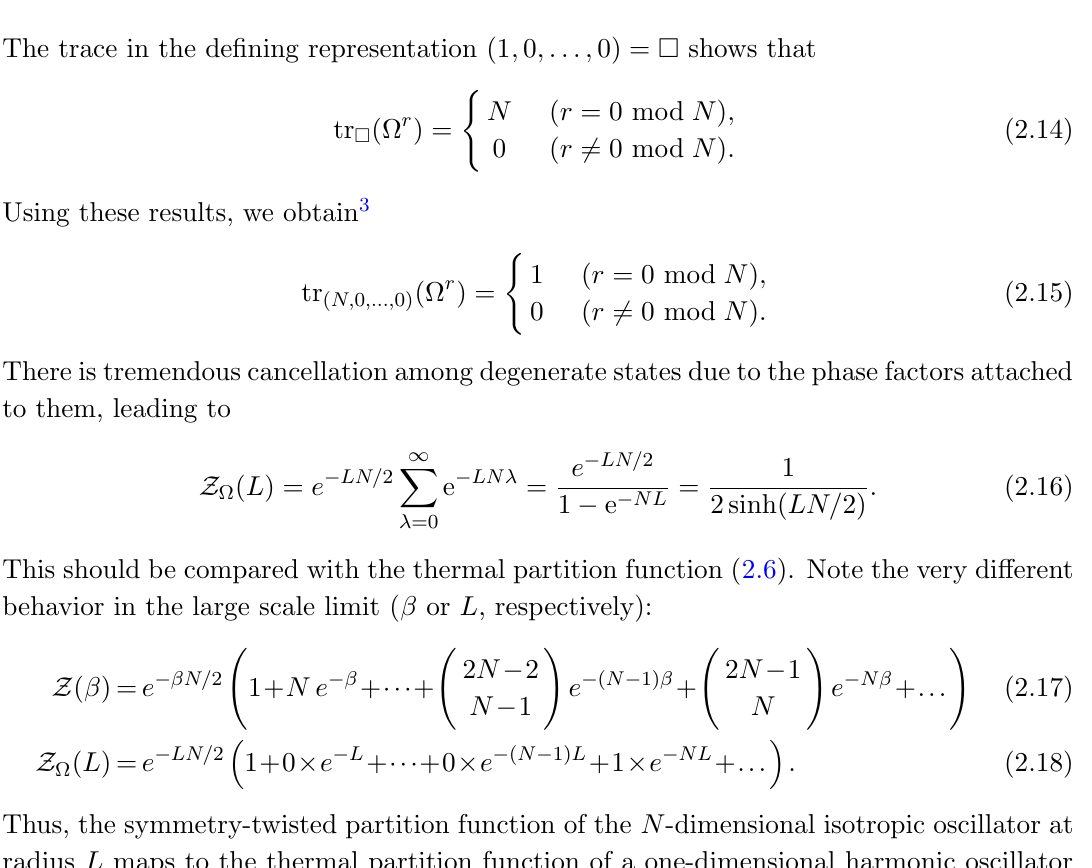
Figure 2 . Schematic image for the graded partition function (2.12) for an N -dimensional isotropic simple harmonic oscillator, with N = 4, showing the representations with (cid:21) = 0 ; 1 ; 2, corresponding to energy E (cid:21) = N + (cid:21) . Since the phases q n = exp(2 (cid:25)in= 4) are attached to the states, most of them 2 cancel with one another, and we obtain the information of the ground states. We will see that a similar structure is also present in certain